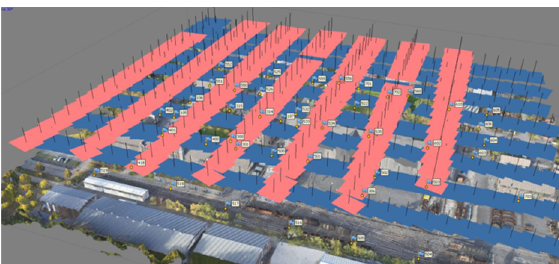
Figure 4. Flight arrangement Regular (R) and Cross (C), (Image block with Zenmuse X4S)